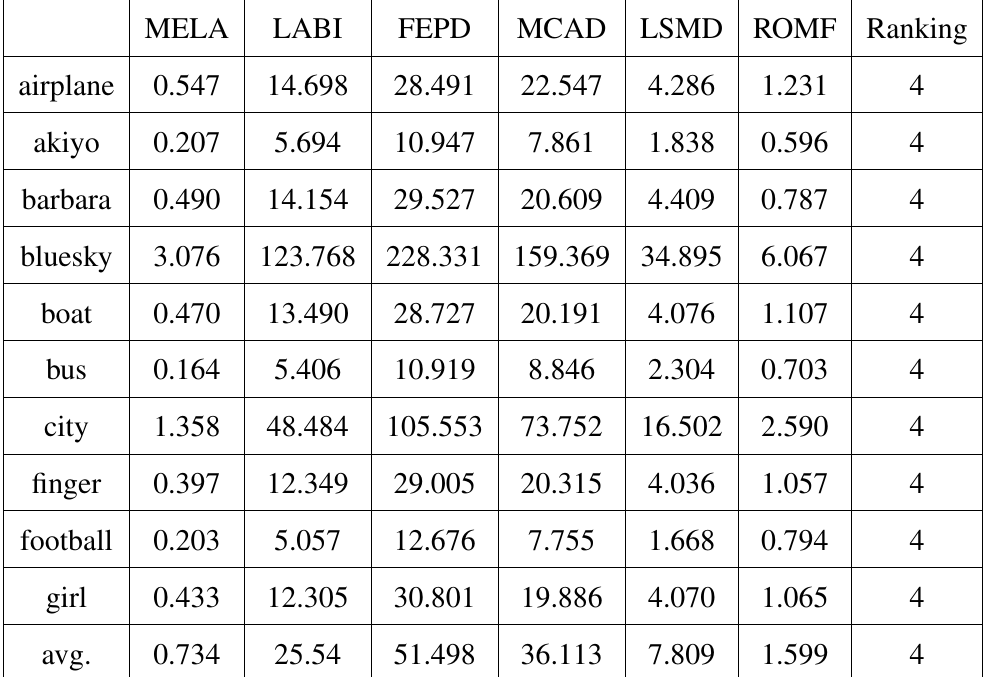
Table 3. Comparison of the average CPU time for 10 test images and video sequences among different deinterlacing